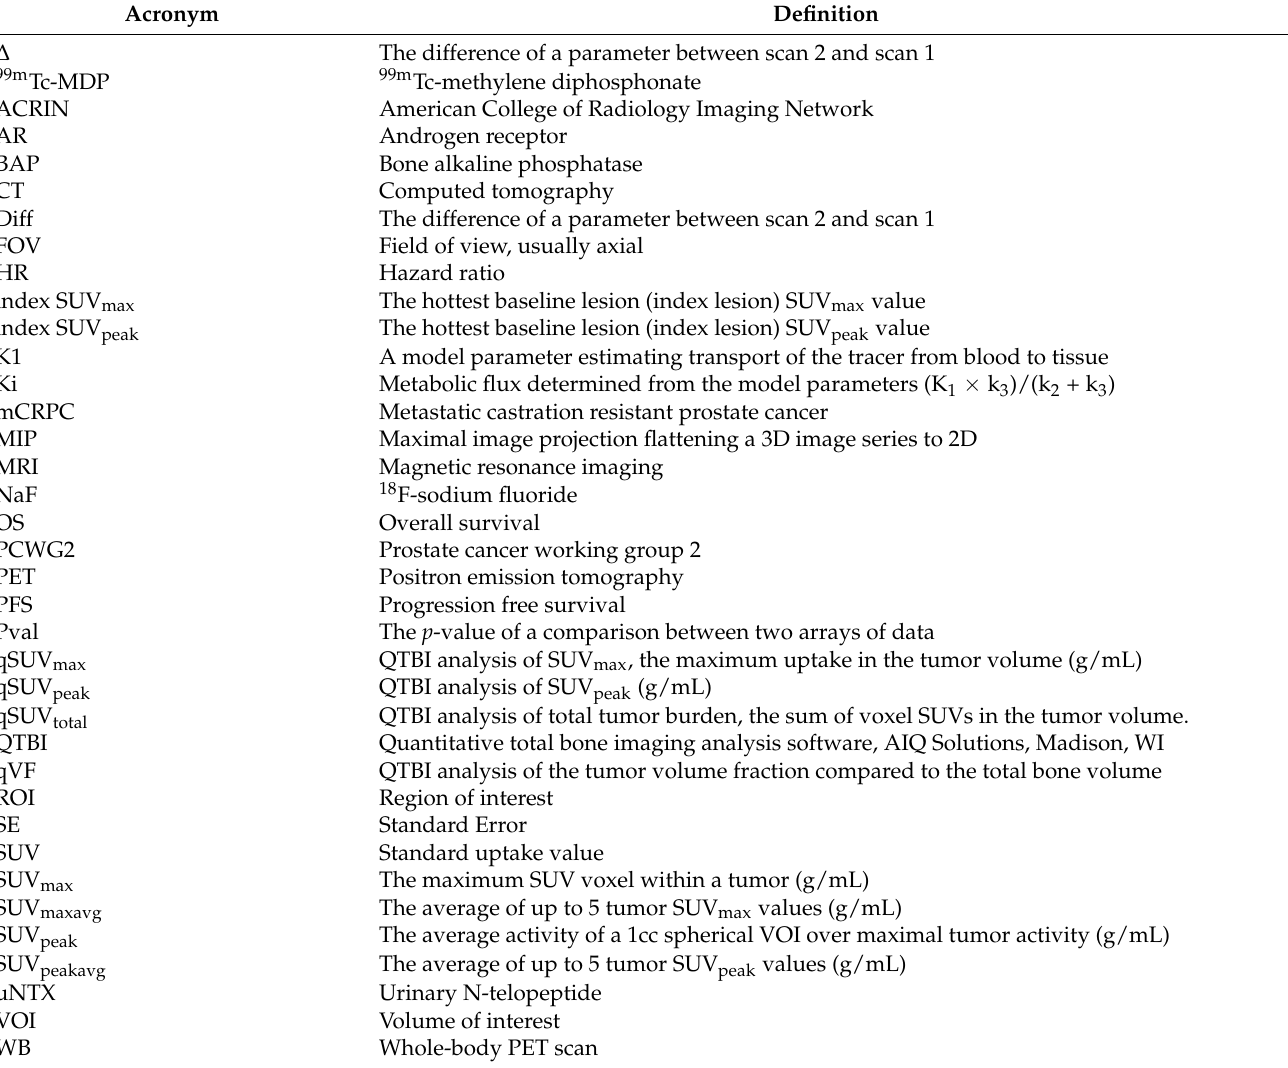
Table 1. Definition of